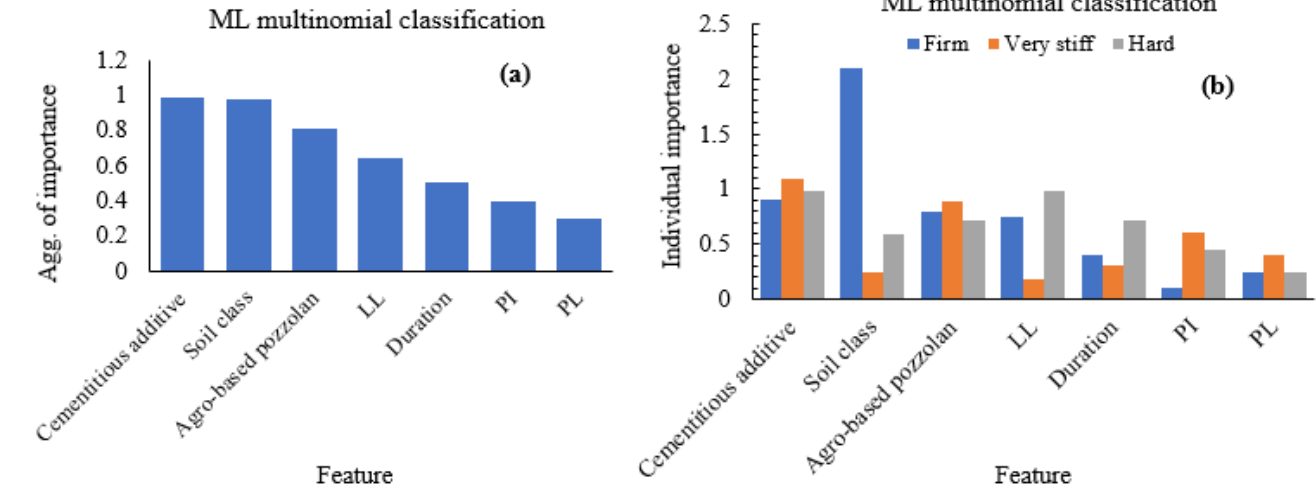
Figure 10. Multinomial classification feature importance. ( a ) Aggregate importance, ( b ) individual importance.